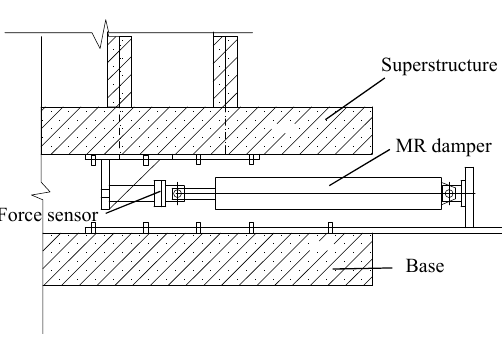
Figure 5. MR damper.